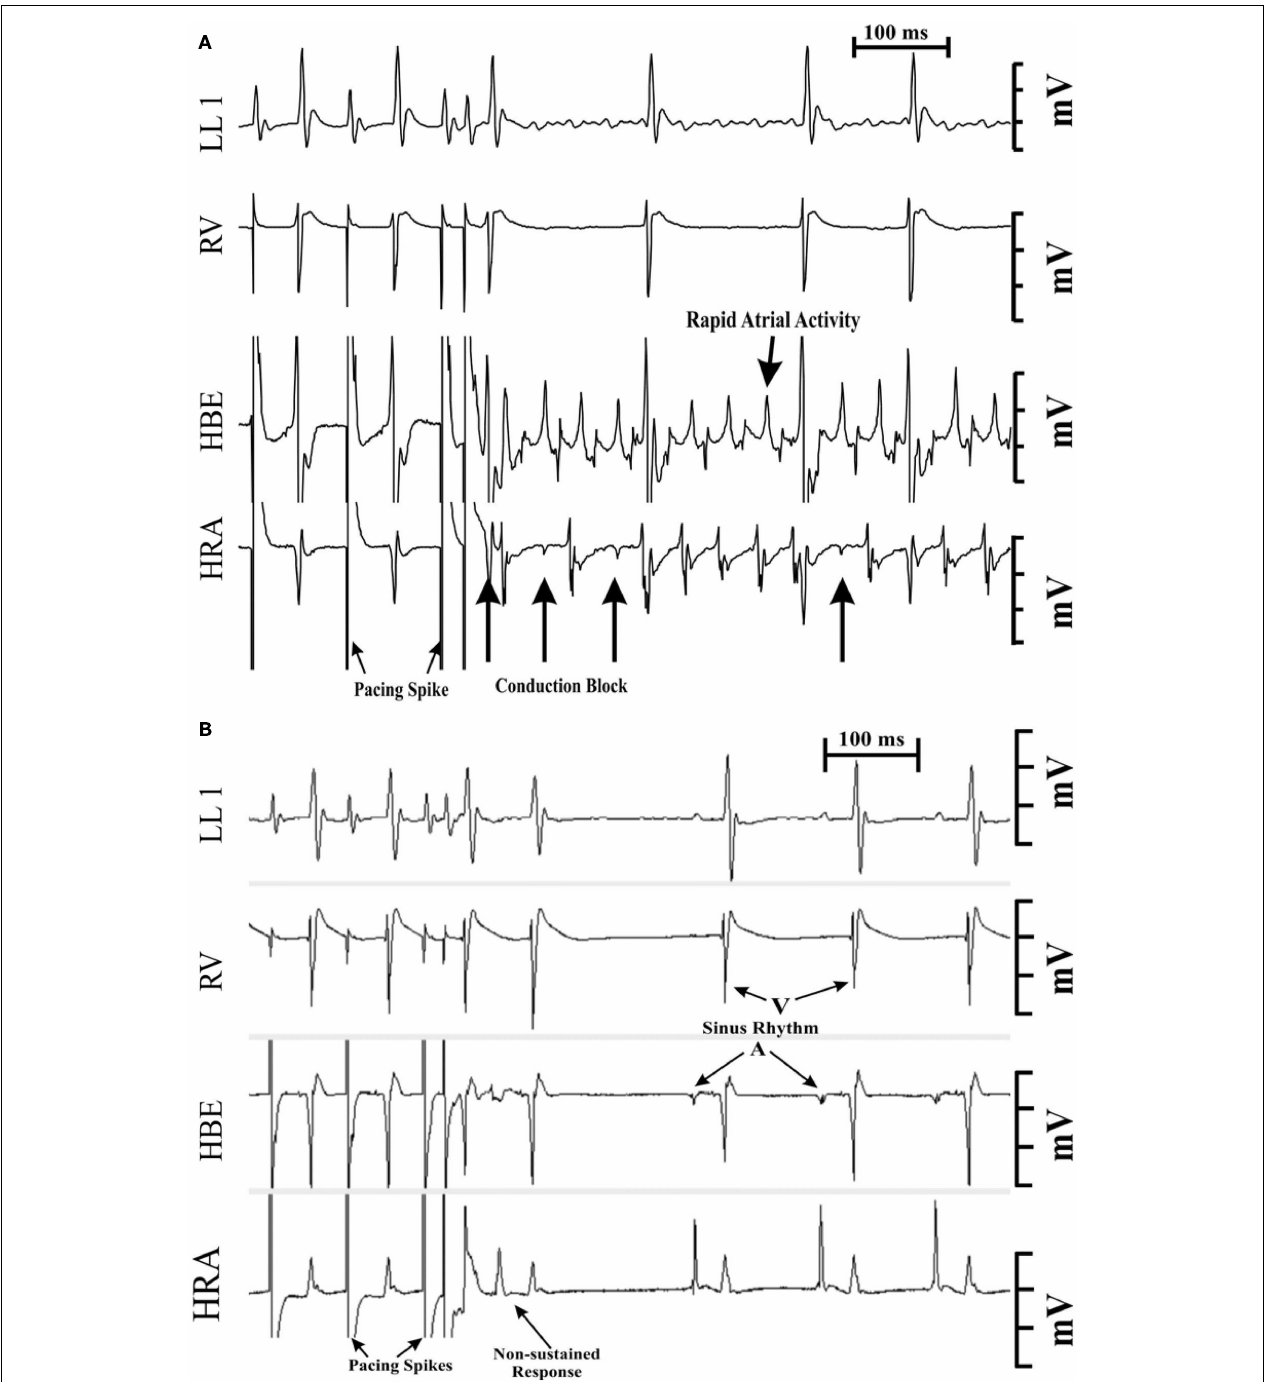
with an average atrial rate of ∼ 1600bpm. A similar stimulation protocol failed to induce atrial fibrillation in wild type mice (B) . LL1, limb lead 1.RV, right ventricular electrogram. HBE, electrogram from the His bundle region. HRA, recording from the high right atrium.